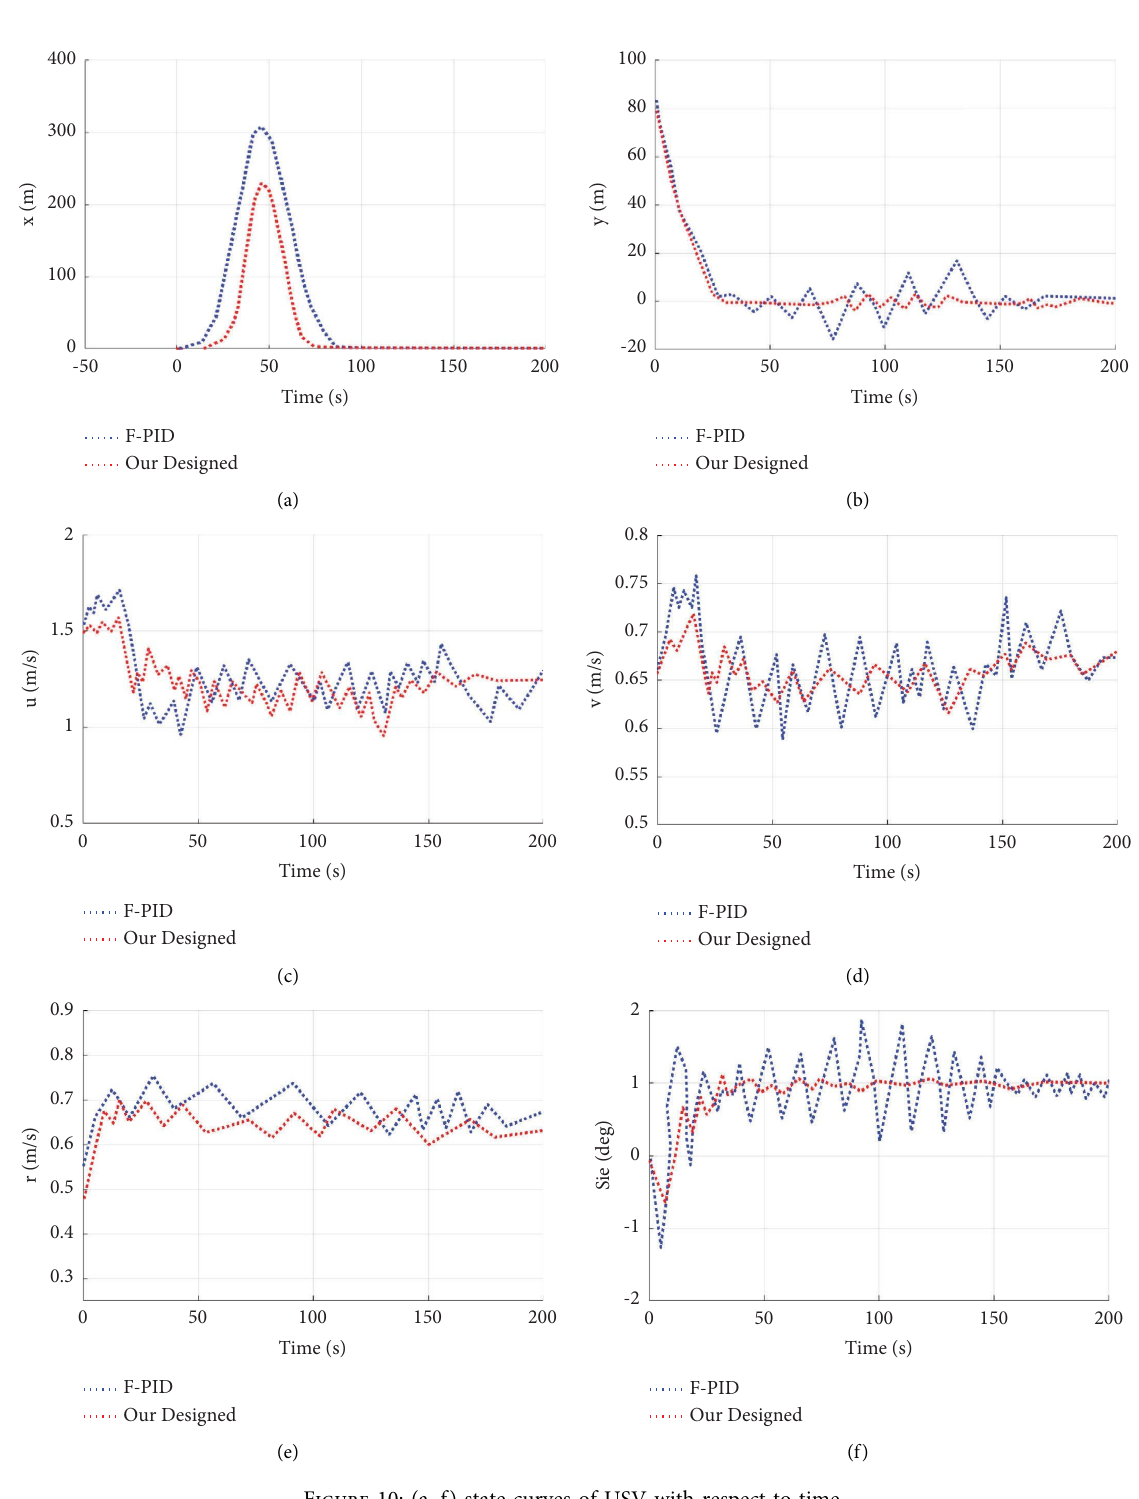
Figure 10: (a–f) state curves of USV with respect to